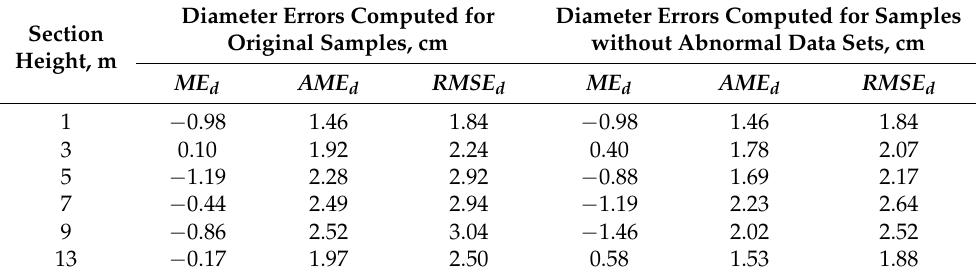
Table 5. Mean error ( ME d ), absolute mean error ( AME d ), and root mean squared error ( RMSE d ) in measuring upper-stem diameters using a laser caliper for six sections along the